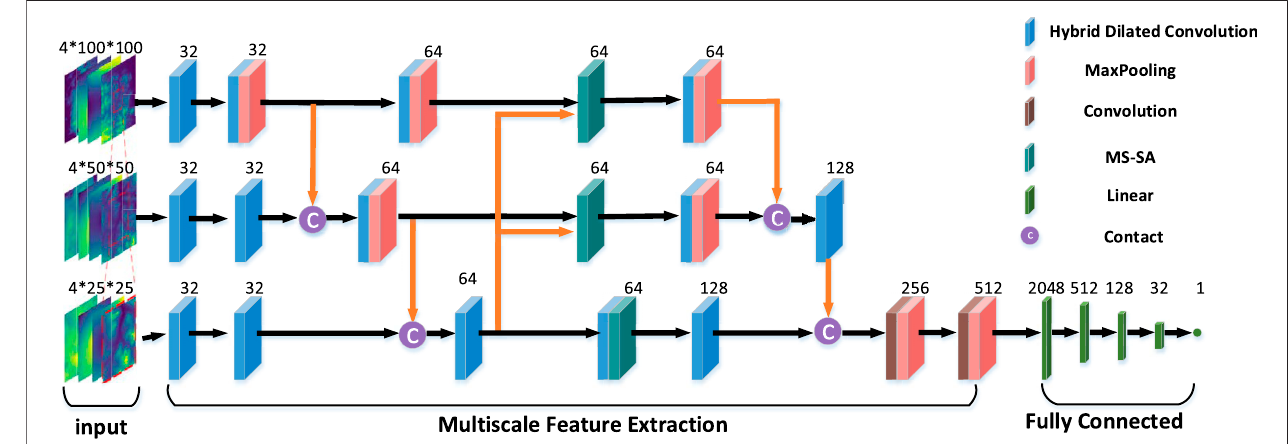
FIGURE 3 | The MS-FCVNet model receives information input from three scales, undergoes multi-scale feature extraction and fusion, and fi nally outputs the predicted values through a fully connected layer.